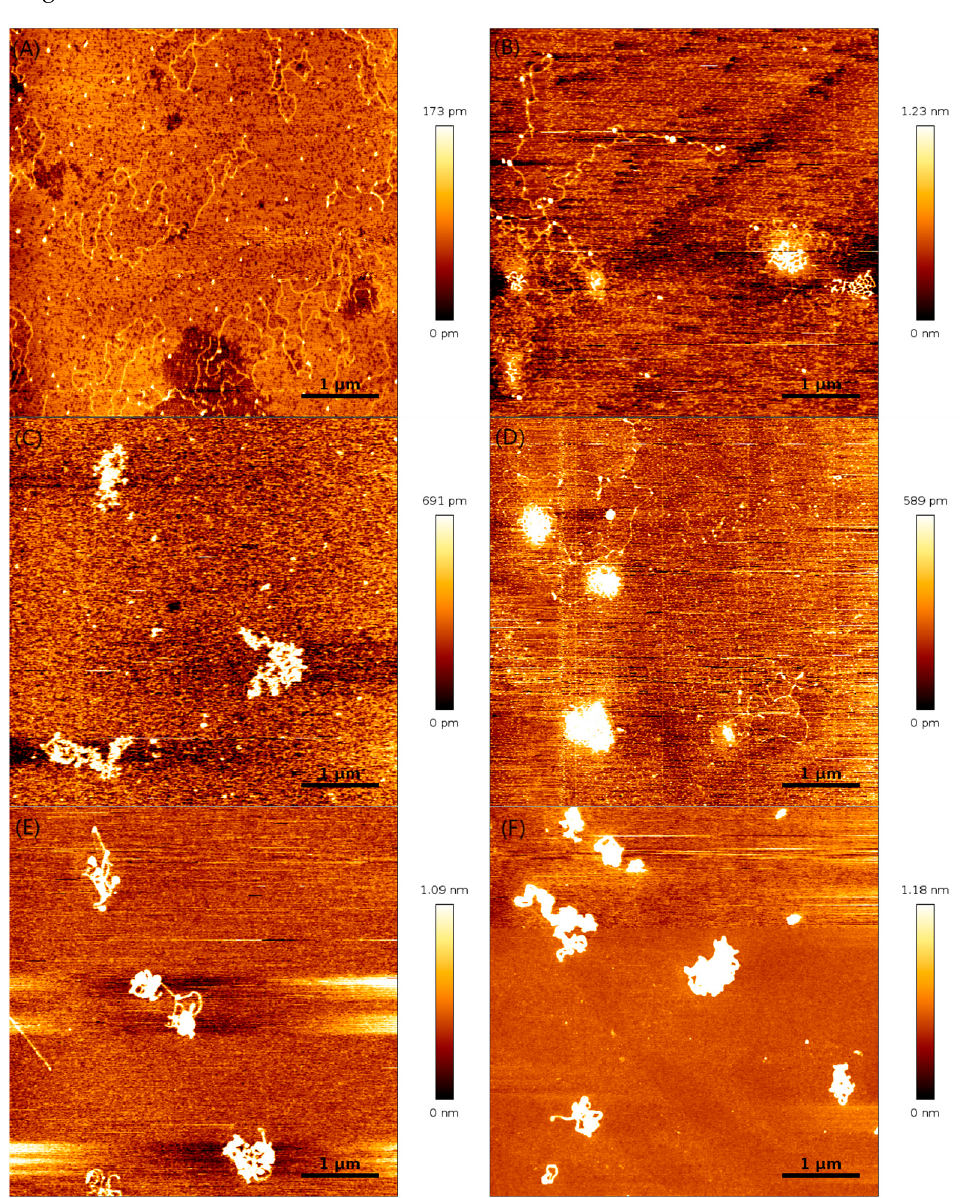
Figure 7. Atomic force images of DNA–lysozyme complexes at different lysozyme concentrations (pH = 7). (( A ) 0 ng · µ L − 1 lysozyme; ( B ) 6 ng · µ L − 1 lysozyme; ( C ) 10 ng · µ L − 1 lysozyme; ( D ) 18 ng · µ L − 1 lysozyme. ( E ) 35 ng · µ L − 1 lysozyme. ( F ) 50 ng · µ L − 1